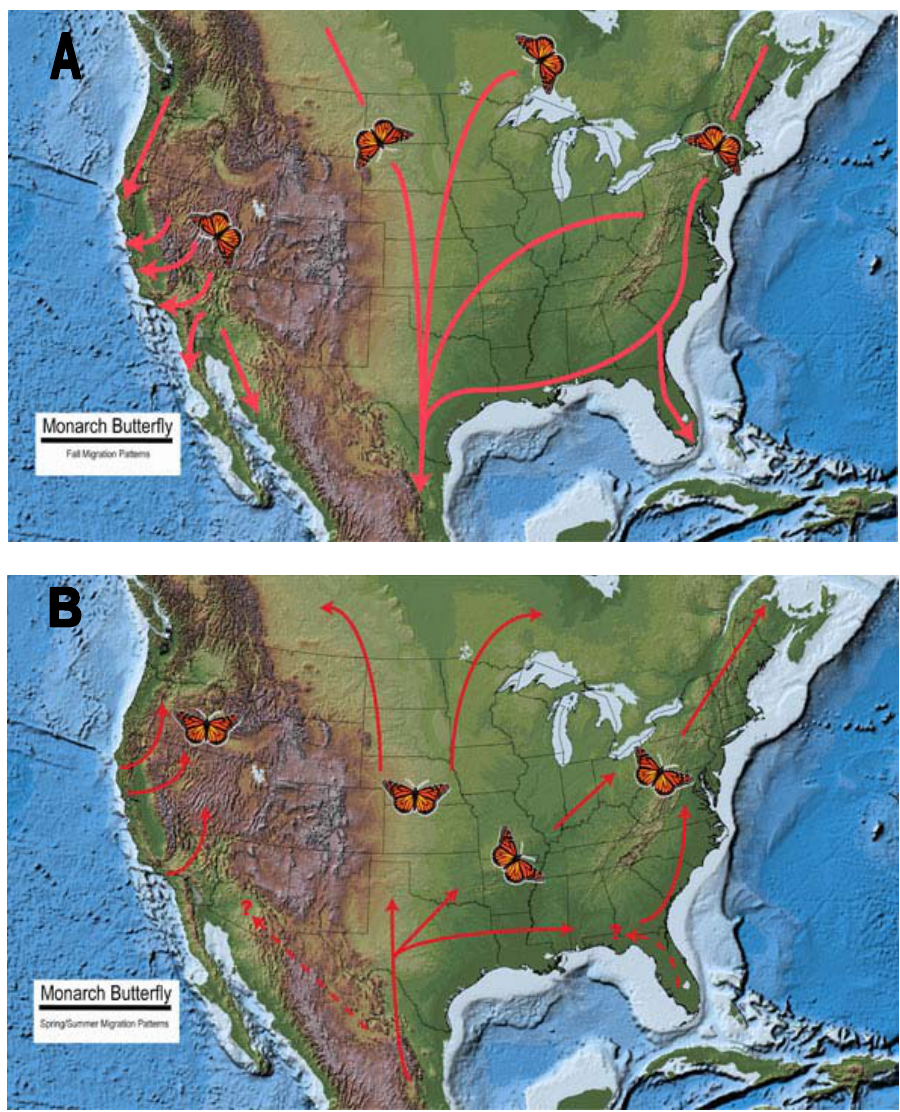
Figure 2. A. Fall migration of Monarch butterflies. B. Spring/summer migration of Monarch butterflies (Adapted from U.S. Fish and Wildlife Service. 2007. Provided by Environment